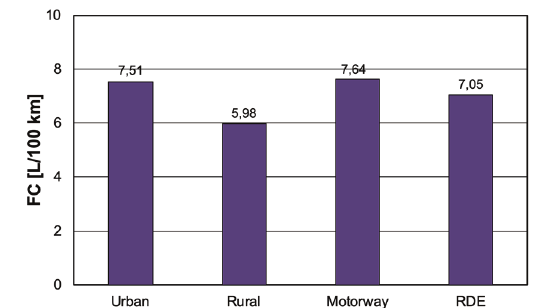
Fig. 10. Fuel consumption in respective RDE cycle phases and average fuel consumption in this